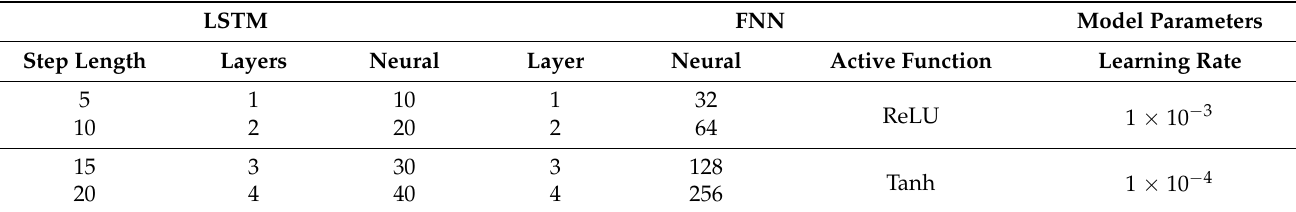
Table 2. LSTM–FNN model parameter combination.